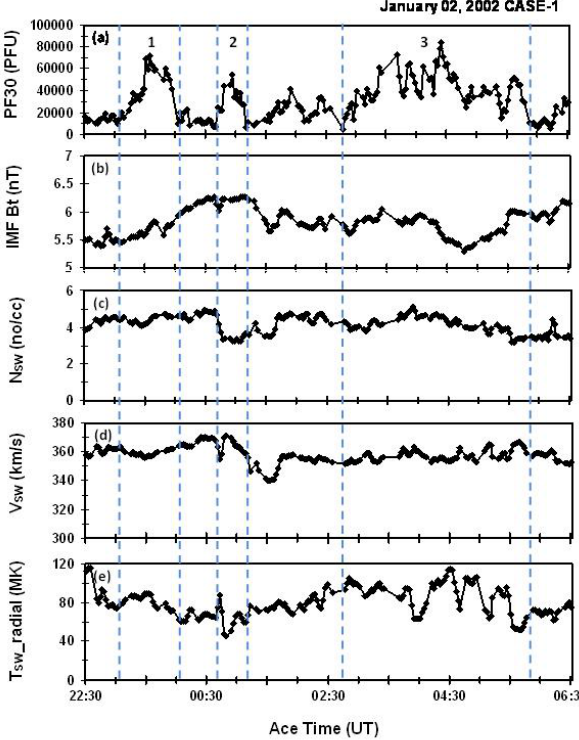
Fig. 9b. ACE solar wind plasma data for 2 January 2002. From top to bottom, panels give (a) PF30, (b) IMF strength, (c) density, (d) speed, and (e) proton temperature (radial) versus time. PF30 was added to guide the features in Cluster data. IMF strength was included for easy comparison. Cluster data were shifted to the ACE times concurrently to account for the solar wind convection time from ACE to Cluster. Horizontal axis indicates the time at ACE